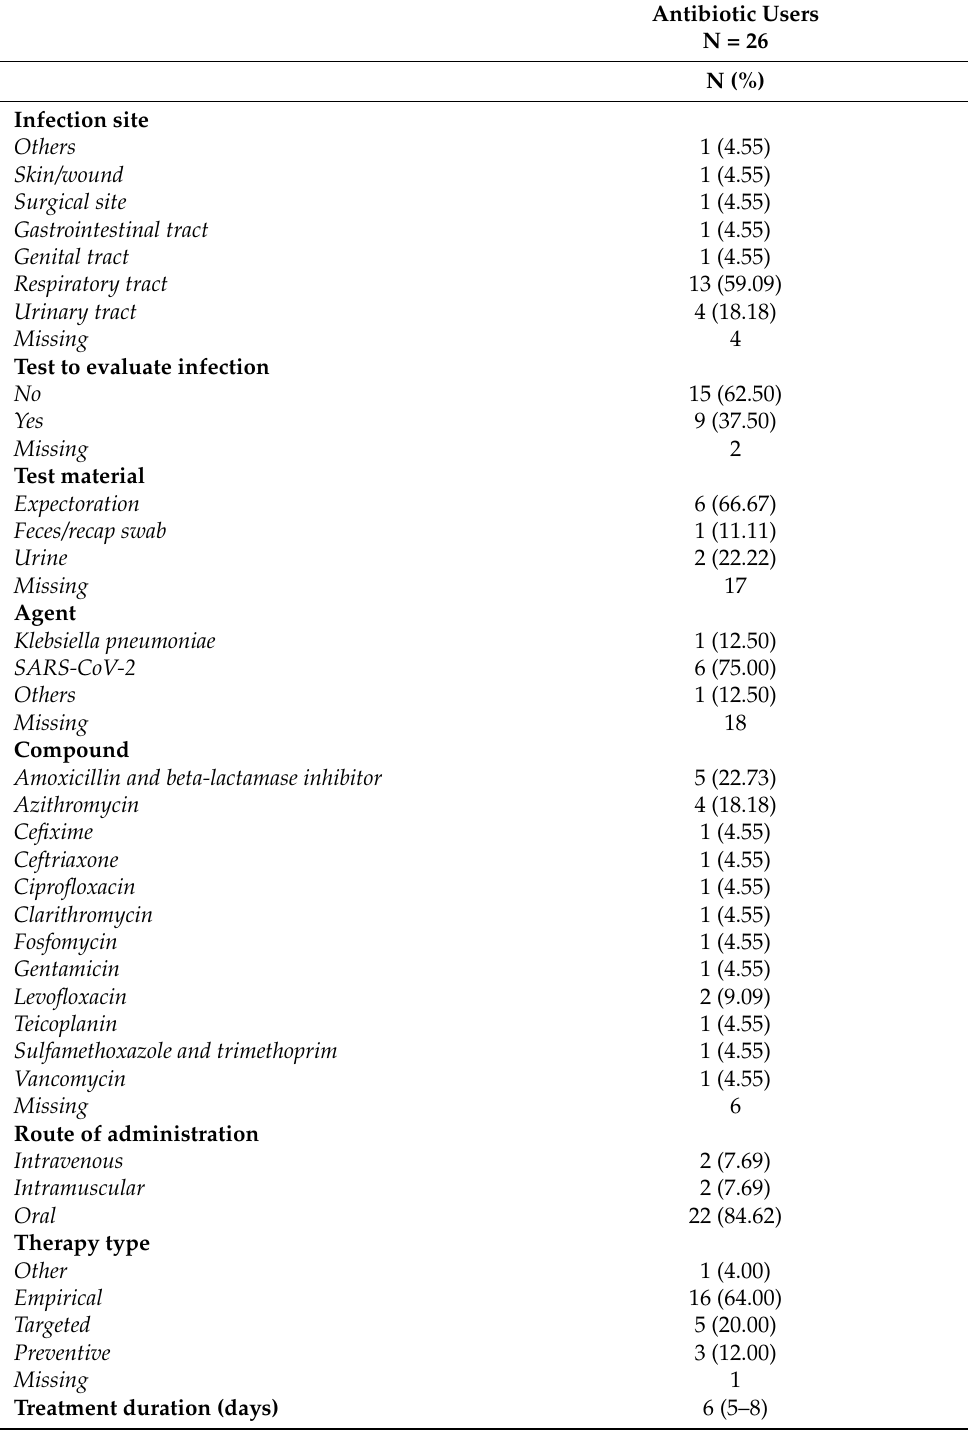
Table 2. Characteristics of antibiotic use and the test used to identify